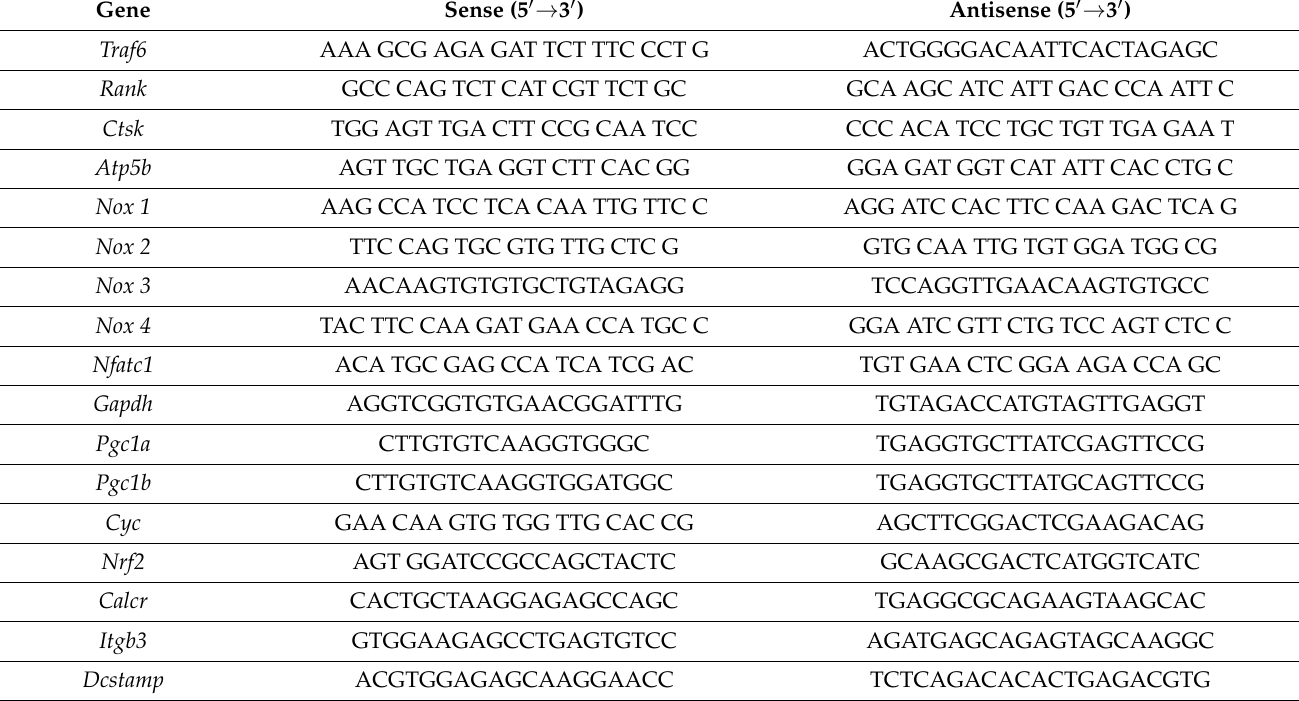
Table 1. Sequences of the primers used in the gene expression